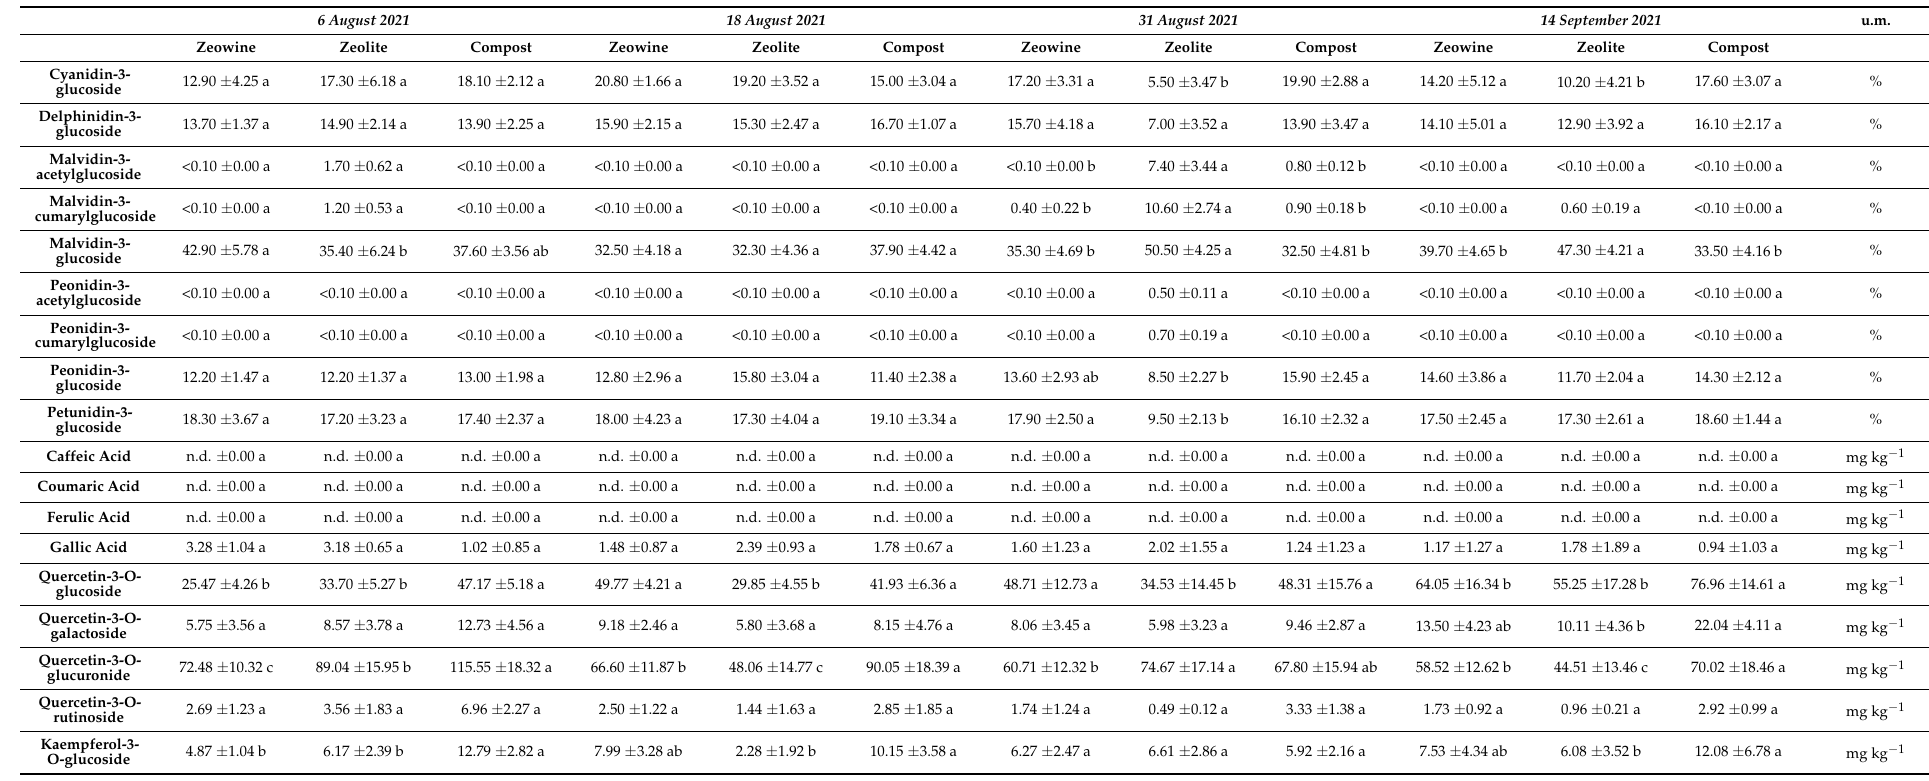
Table 1. Phenolic maturity. Fractionation of anthocyanins (Cyanidin-3-glucoside, Delphinidin-3-glucoside, Malvidin-3-acetylglucoside, Malvidin-3-cumarylglucoside, Malvidin-3-glucoside, Peonidin-3-acetylglucoside, Peonidin-3-cumarylglucoside, Peonidin-3-glucoside, and Petunidin-3-glucoside) and Coumaric Acid, Gallic Acid, Caffeic Acid, Ferulic Acid, Kaempferol-3-O-glucoside, Quercetin-3-O-glucoside, Quercetin-3-O-rutinoside, Quercetin-3-O-galactoside, and Quercetin-3-O- glucuronide of Vitis vinifera treated with Zeowine, Zeolite, and Compost during the 2021 season. Measurements were conducted four times: full veraison (29 July 2021 and 18 July 2022), mid-maturation (18 August 2021 and 4 August 2022), full maturation (31 August 2021 and 17 August 2022), and harvest (14 September 2021 and 5 September 2022). Data (mean ± SE, n = 10) were subjected to one-way ANOVA. Different letters indicate significant differences between Zeowine, Zeolite, and Compost (LSD test, p ≤